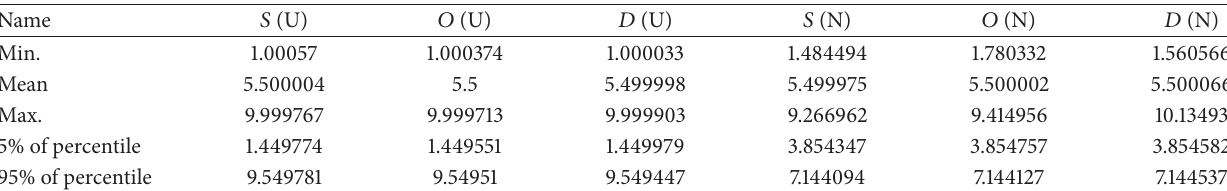
Table 5: The statistics of simulation input functions.